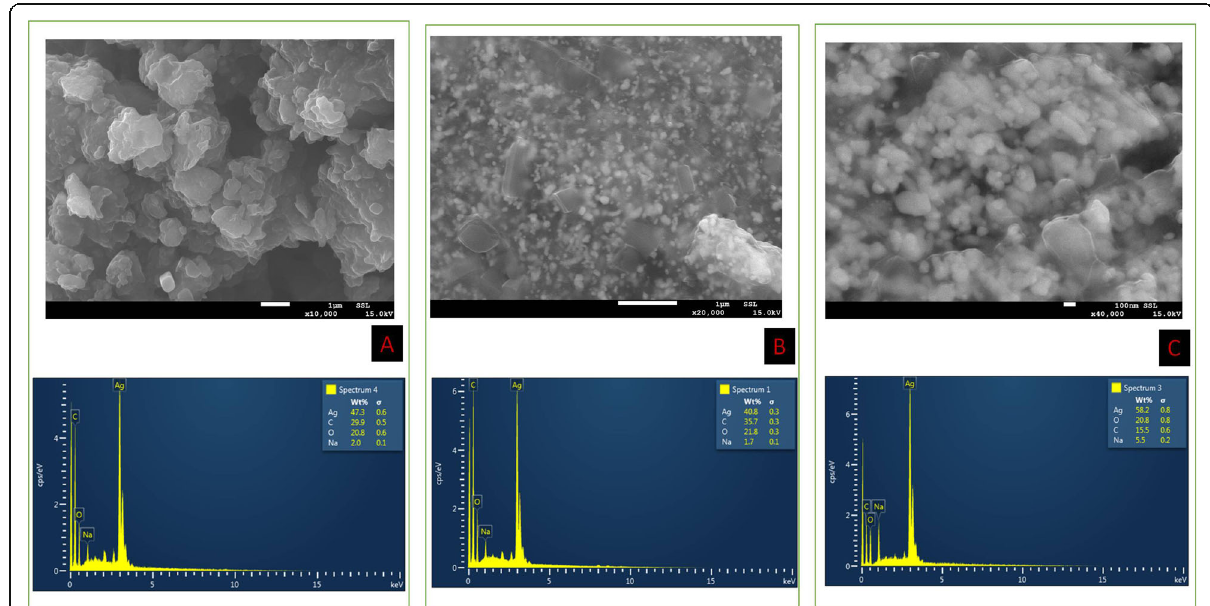
Fig. 5 a – c . Microphotographs showing surface characteristics and composition of biosynthesized AgNPs by FE-SEM-EDX analysis. a P-AgNPs. b Q-